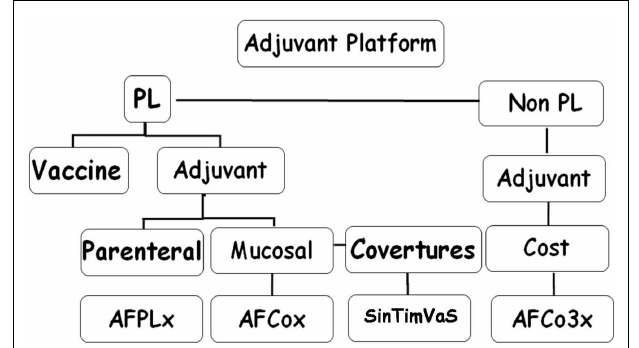
FIGURE 2 | Three main microbial-associated molecular patterns present inAFPL1 andAFCo1 . Lipopolysaccharide (LPS) Porin B (PorB), and traces of bacterial DNA detected by SDS-PAGE stained with Coomassie blue for PorB and silver staining for LPS and agarose gel for